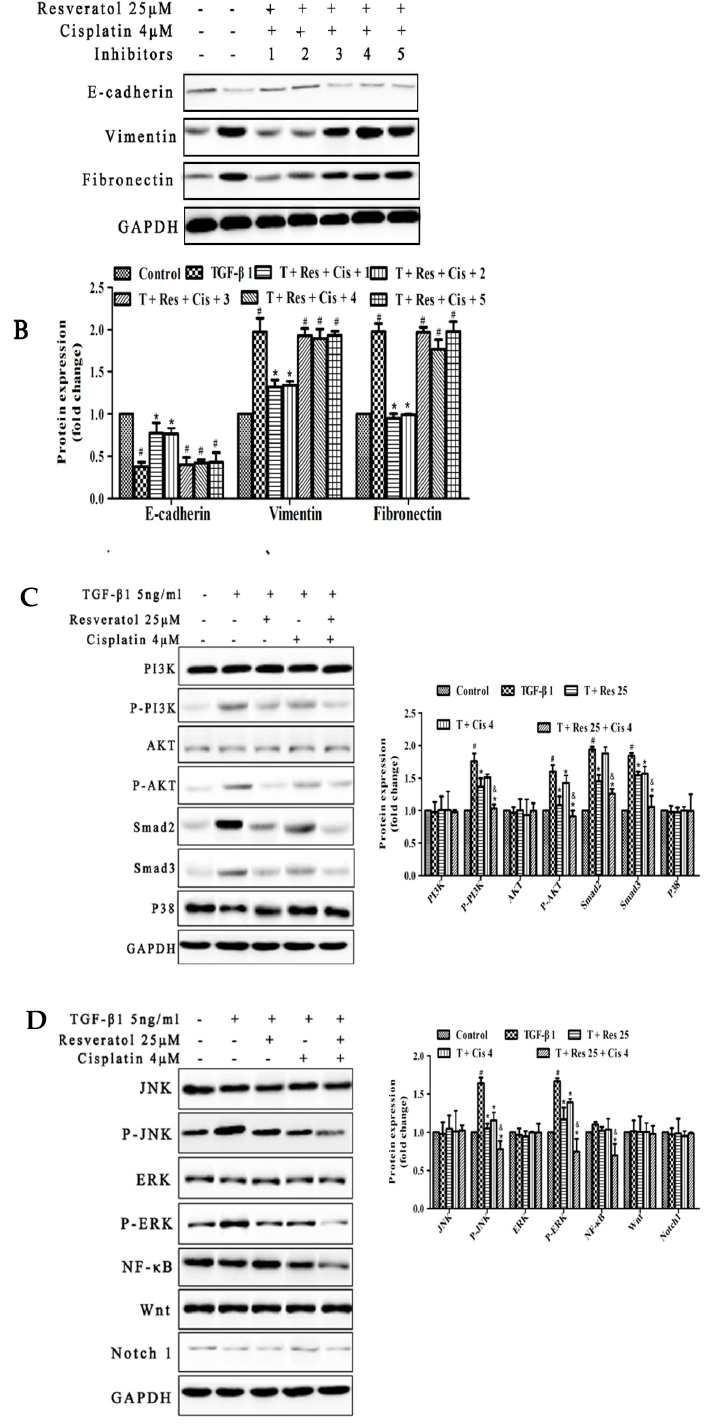
Figure 4. Effects of resveratrol and cisplatin on EMT-related pathway proteins induced by TGF- β 1 in MDA231 cells. ( A ) Expressions of epithelial and mesenchymal markers by the treatment of signaling pathway inhibitors; ( C ) Expressions of EMT-related pathway proteins ( B , D ) protein expression fold change. T, TGF- β 1 5 ng/mL; 1, LY290042; 2, SB431542; 3, SP600125; 4, PD98059; 5, PDTC. The experiment was repeated three times, # p < 0.01, vs. control group; * p < 0.05, vs. TGF- β 1-treated group; & p < 0.01, compared to TGF- β 1 + cisplatin-treated